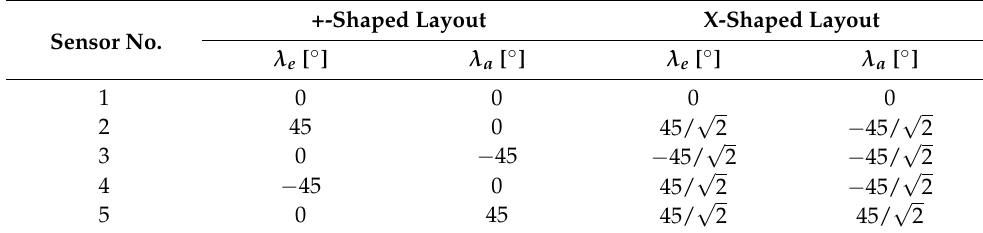
Table 1. Transformation angles from BCS B to SCS I.